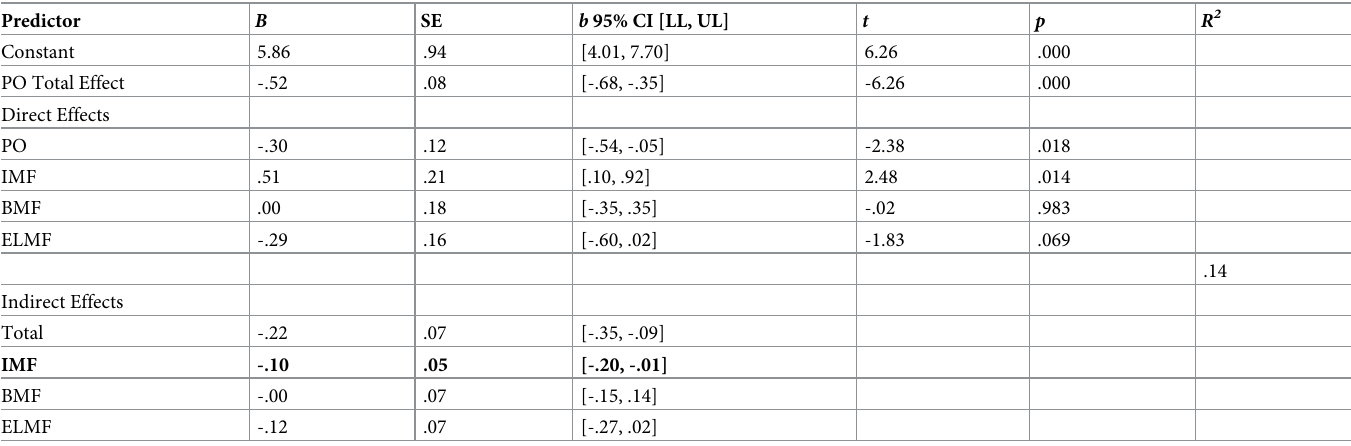
Key: PO: Political Orientation; IMF: Individualizing Moral Foundations; BMF: Binding Moral Foundations; ELMF: Economic Liberty Moral Foundation. Significant indirect (mediation) effects indicated in bold